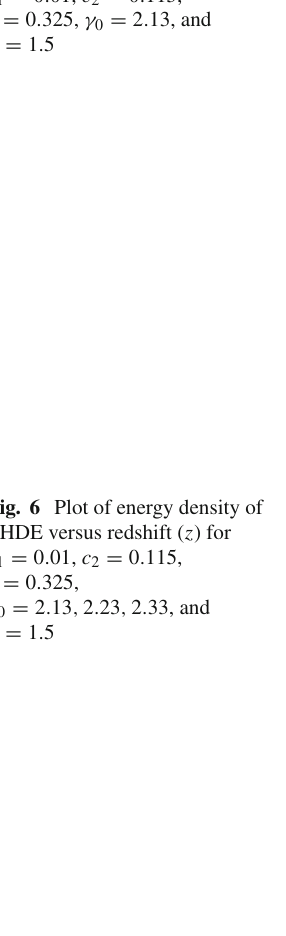
Fig. 6 Plot of energy density of THDE versus redshift ( z ) for c 1 = 0 . 01, c 2 = 0 . 115, k = 0 . 325, γ = 2 . 13 , 2 . 23 , 2 . 33, and 0 α = 1 .